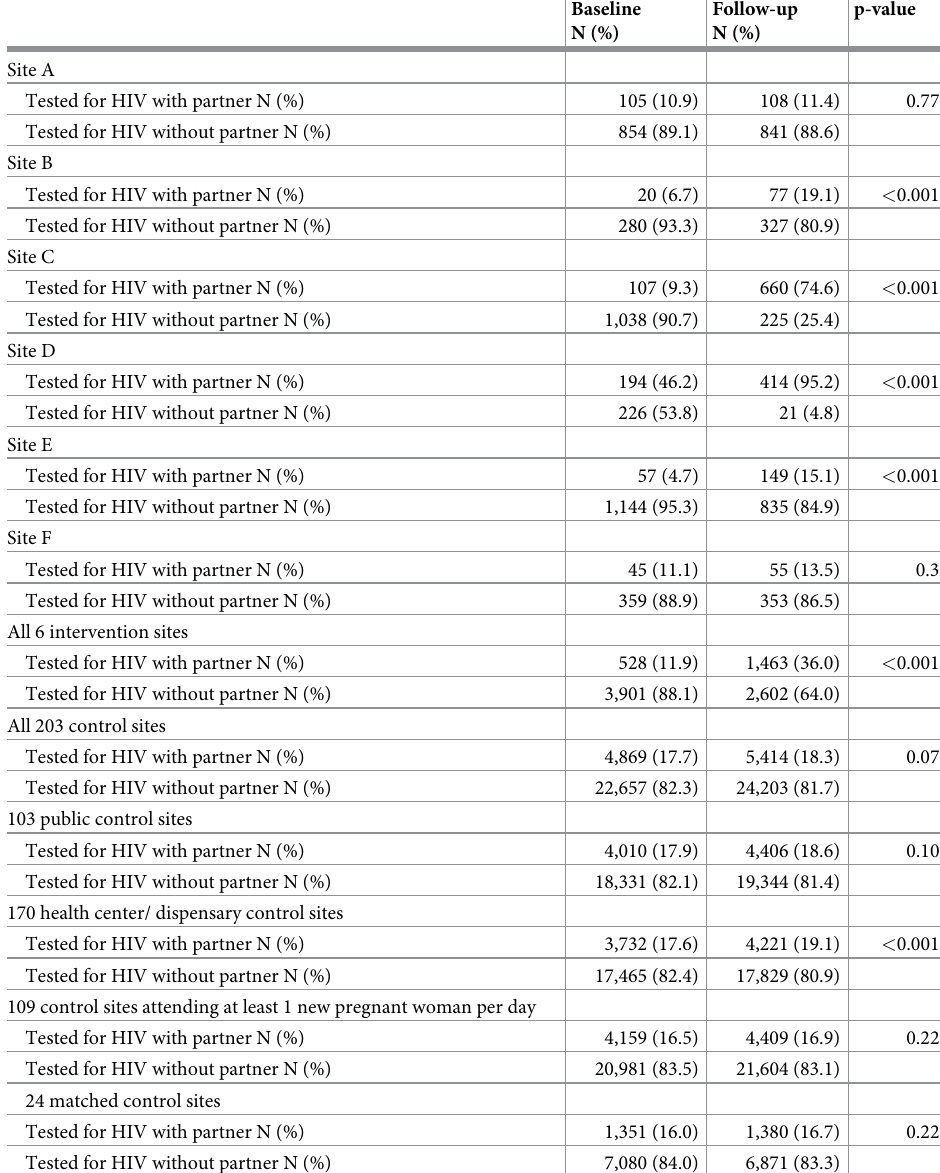
Table 2. HIV testing rates at baseline (January—March 2015), prior to the male partner intervention, and at 1-year follow-up (January—March 2016) at 209 health facilities in Dar es Salaam,